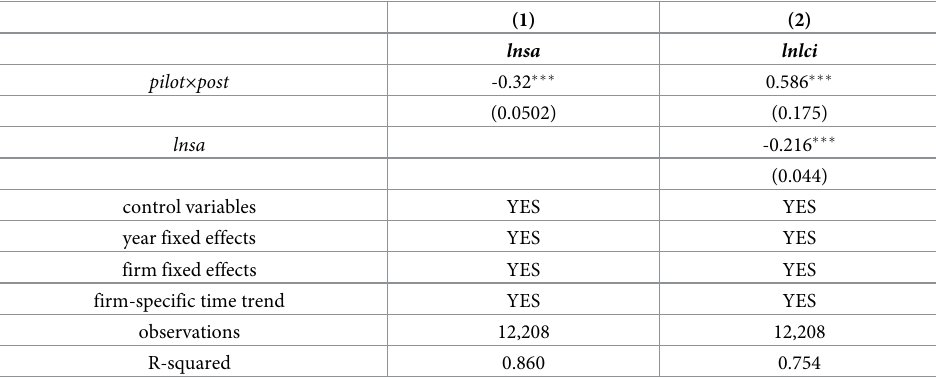
Table 6. Mechanism